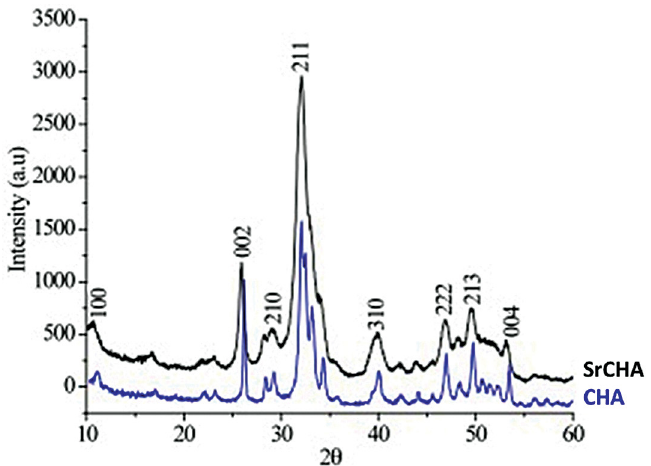
Figure 1- XRD pattern of CHA and SrCHA. The peaks of SrCHA are narrower than those of CHA, indicating low cristallinity for SrCHA when compared to the CHA group